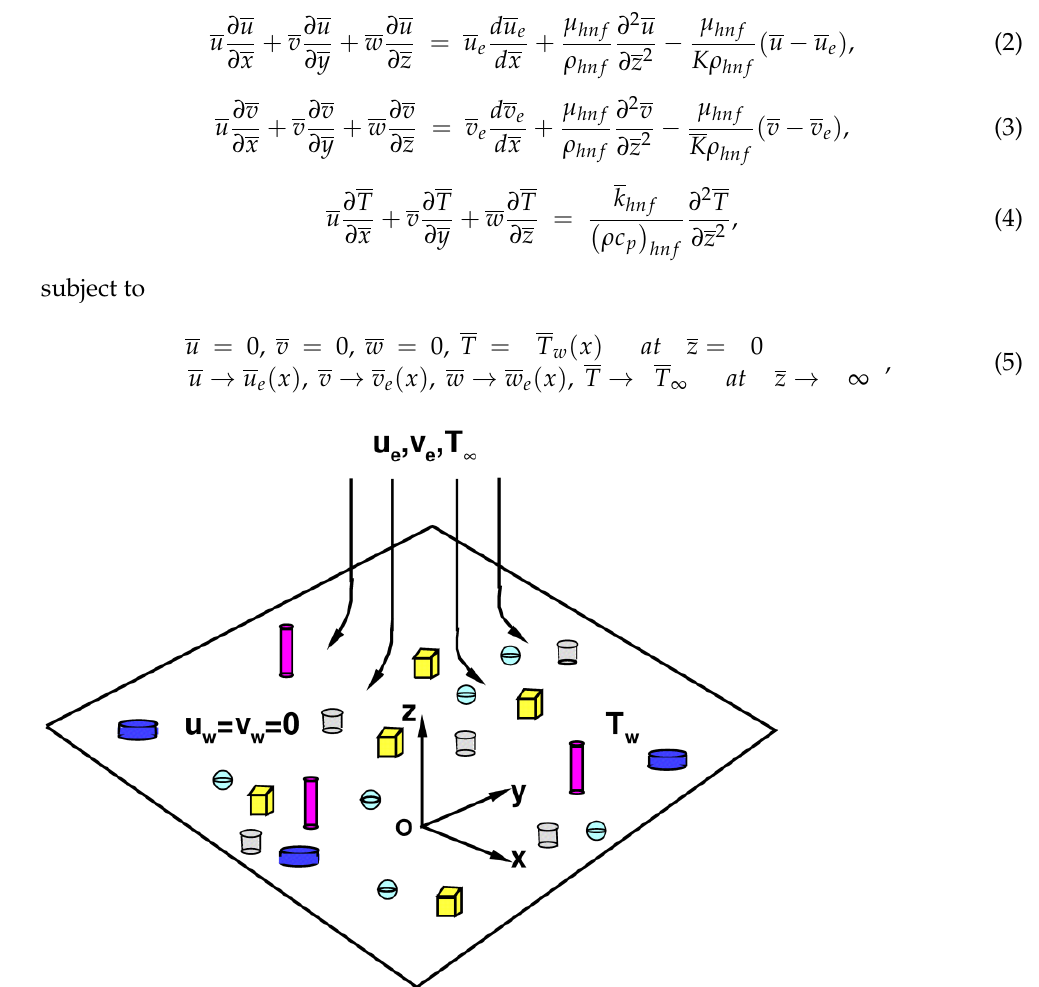
Figure 1. Physical model and coordinate systems.